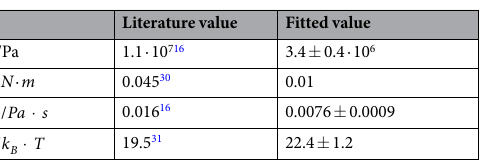
Literature value